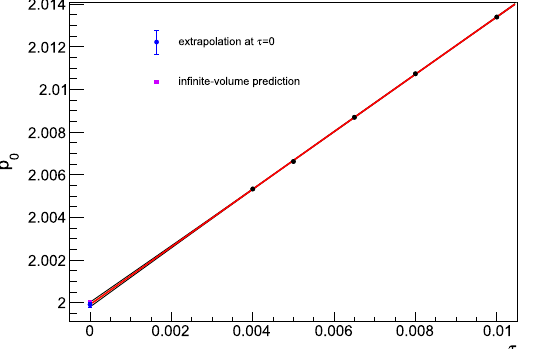
Fig. 6 Determination of p 0 , p 1 at L = 48. Dedicated simulations for these two coefficients have been performed at τ = 0 . 004 and τ = 0 . 0065. We extrapolate to zero time step with a second order